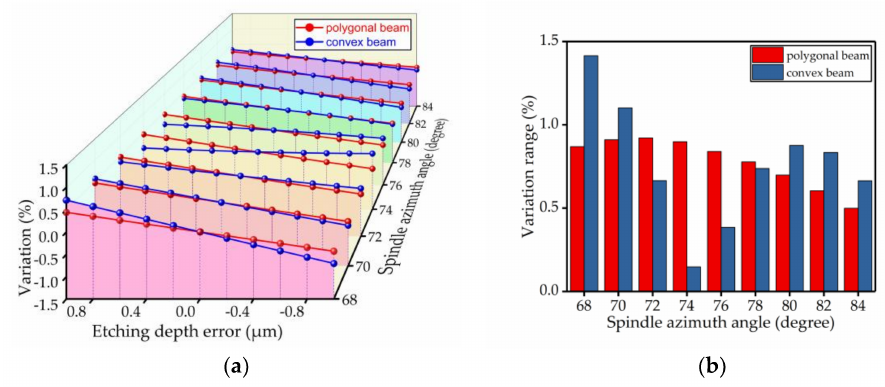
Figure 11. The influence of the etching depth error on the spindle azimuth angle of the polygonal cross-section beam and the convex cross-section beam; ( a ) shows the relationship between spindle azimuth angle variation and etching depth error; ( b ) shows the range of variation—the value is the difference between the maximum and minimum values of each line.